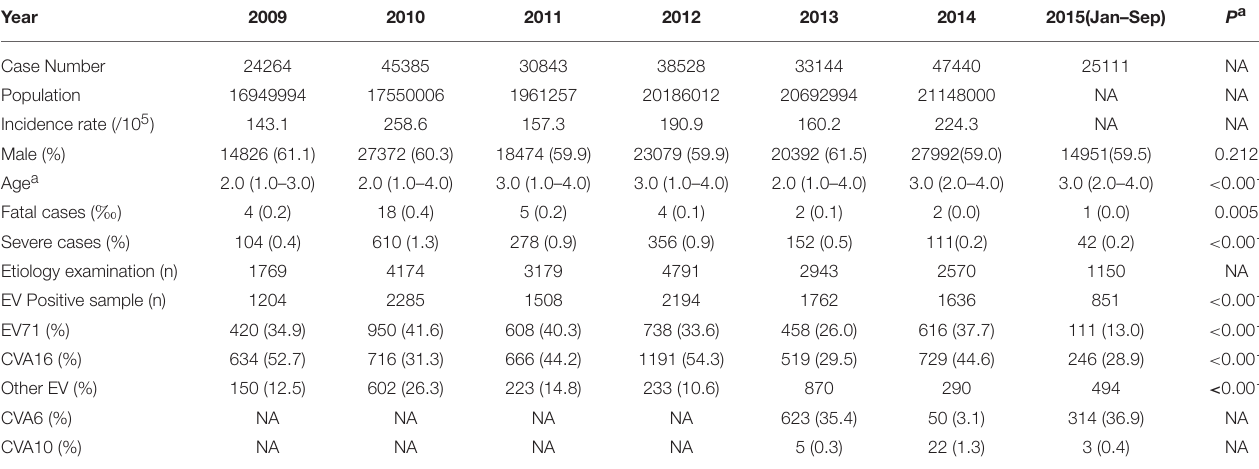
TABLE 1 | The epidemiology and pathogen distribution of HFMD cases in Beijing, China, 2009–2015.